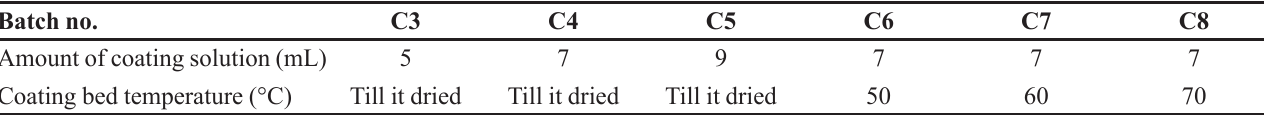
TABLE II - Optimization of coating variables of methotrexate core pellets Batch no.